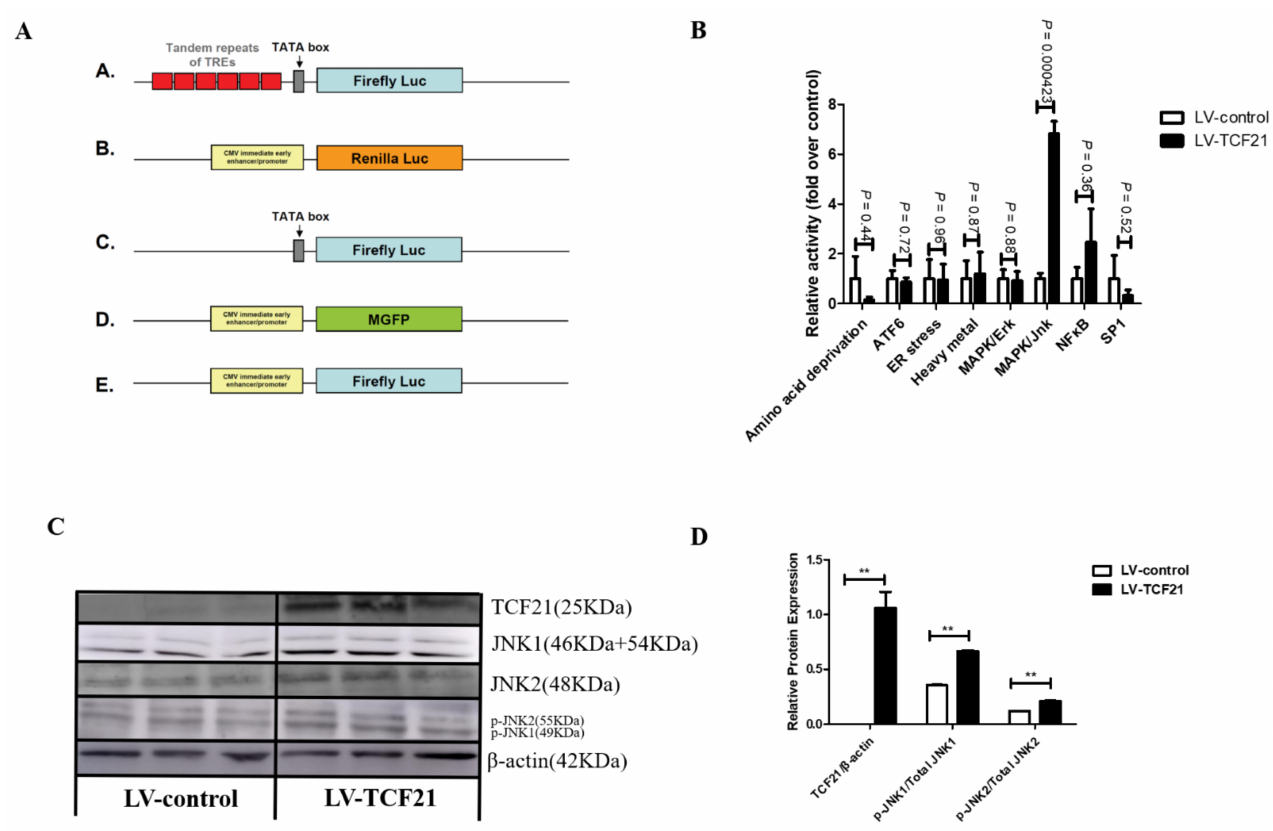
Figure 1. MAPK/JNK signaling pathway was activated by TCF21 overexpression. At 24 h post-induction of differentiation, lysates from LV-control and LV-TCF21 cells were collected. ( A ) A schematic overview of the constructs used for the Cignal Finder 45-Pathway Reporter Array. A. The inducible transcription factor-responsive construct expressing firefly luciferase. B. The constitutively expressing Renilla luciferase construct. C. The non-inducible firefly luciferase reporter construct. D. The constitutively expressing GFP construct. E. The constitutively expressing firefly luciferase construct. The negative control is a mixture of C. and B. (20:1). The positive control is a mixture of D., E. and B. Each reporter is a mixture of A. and B. (20:1). ( B ) A Luciferase activity-based array was used in order to identify those signaling pathways that were responsive to overexpression of TCF21. Graphs are plotted as mean ± SE relative to luciferase activity in LV-control cells from three independent experiments; ( C ) images for TCF21, JNK1, JNK2, p-JNK1, p-JNK2, and β -actin expressions in cells by Western blotting; ( D ) bands intensities were quantified by Image J software. Graphs are plotted as mean ± SE from three independent experiments. ** p <